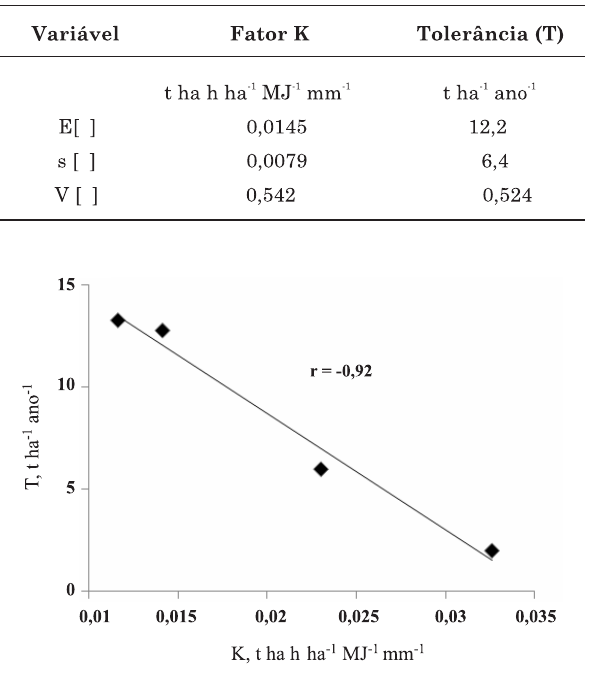
Figura 6. Correlação observada entre a erodibilidade e a tolerância à erosão dos solos da área de